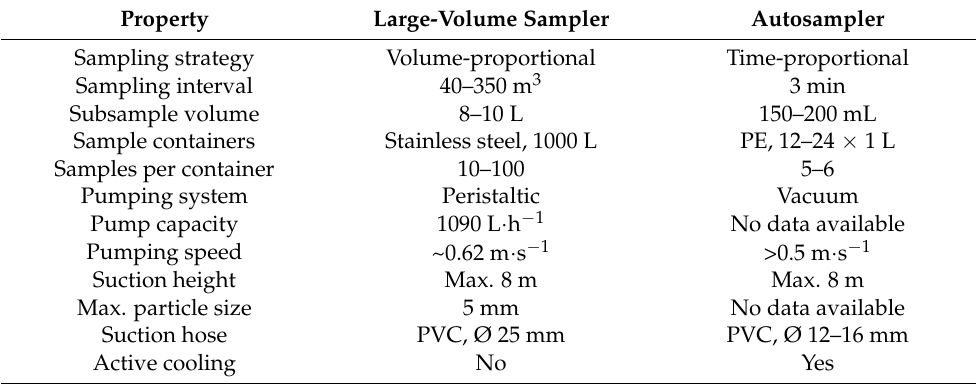
Table 1. Properties of the samplers used in the sampling